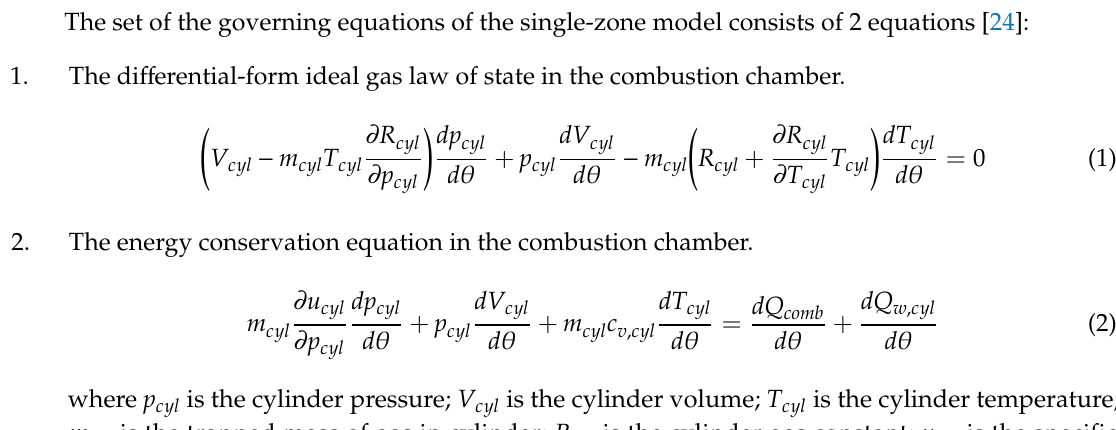
Figure 1. Schematic of a single-zone thermodynamic model.